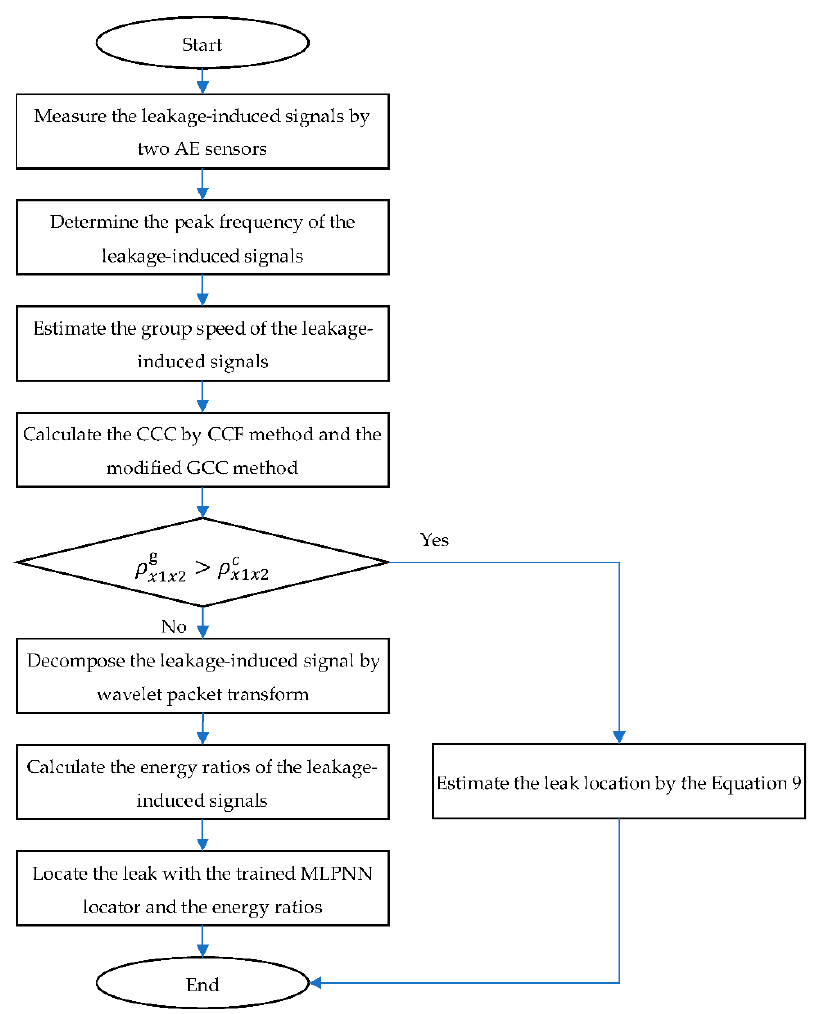
Figure 10. Flowchart of the leakage location method for the MLPNN locator.